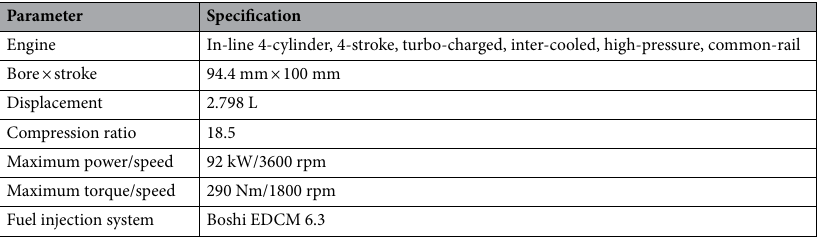
Table 1. Specifications of the test